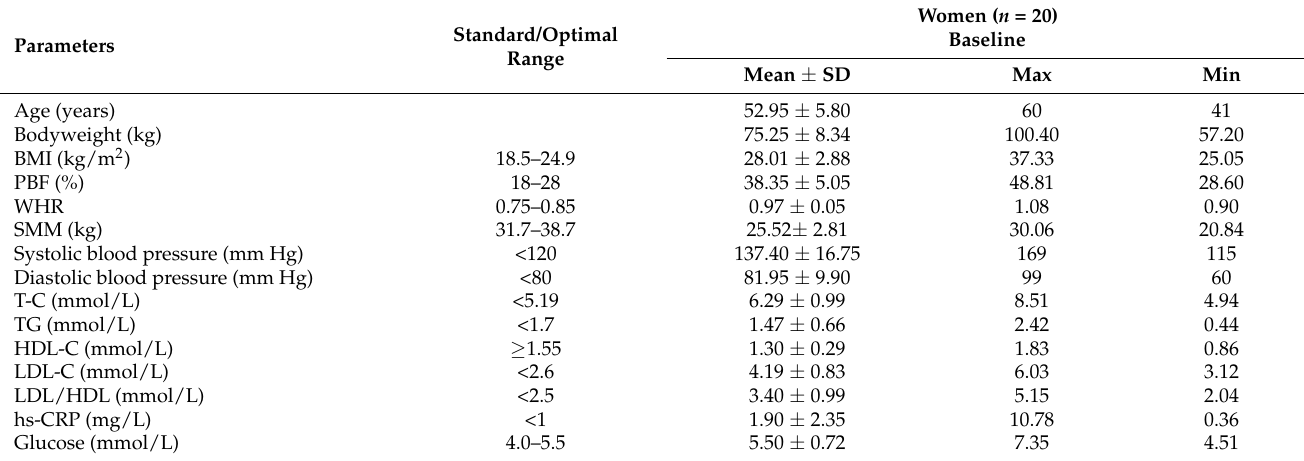
Table 1. Characteristics of the selected participants at baseline.